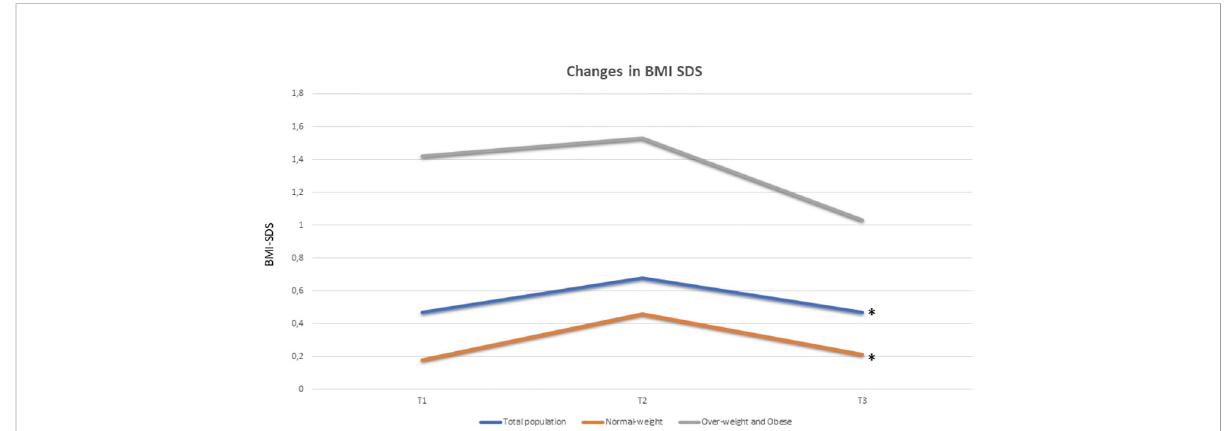
FIGURE 2 Longitudinal changes in BMI SDS (expressed as median) in total population (blue), in group A (33 pre-treatment normal-weight girls, coloured in orange) and in group B (24 pre-treatment over-weight and obese girls, coloured in grey): a signi fi cant rise in BMI SDS during GnRHa therapy was documented in the population ( c 2 11.04, p 0.003) and the normal-weights group ( c 2 10.07, p 0.006), while overweights and obese girls did not show any signi fi cant changes ( c 2 3, 86, p 0.238). At T3, BMI SDS returned near to pre-treatment values both in the total population and in group A, while it seems to decrease respect to pre-treatment mean data in group B (no statistical signi fi cance). Legends: BMI SDS, Body Mass Index Standard Deviation Score; *p<0.05 at Friedman ANOVA